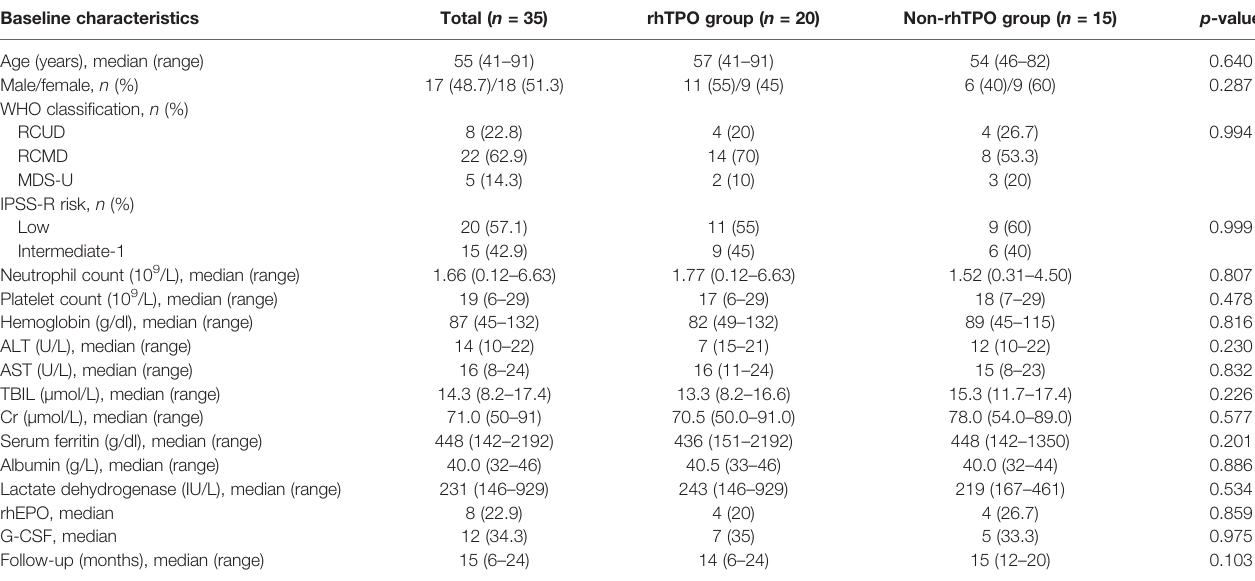
TABLE 1 | Patient characteristics at